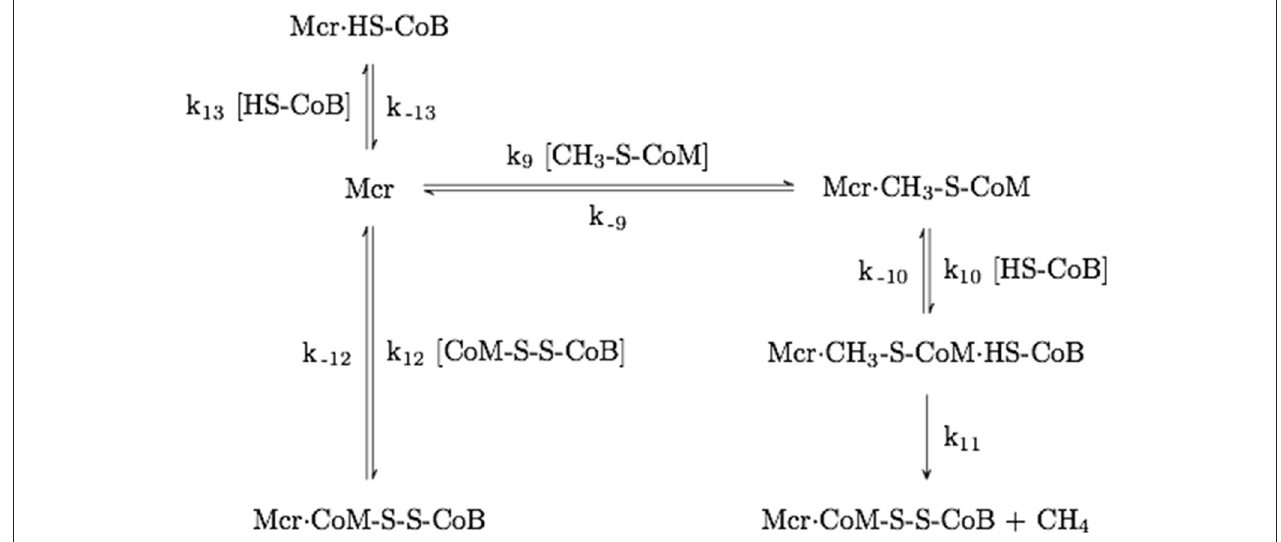
FIGURE 5 | Mechanism of Mcr competitive inhibition by HDS. The rate constant numbering begins with k 9 to avoid ambiguity with the mechanism shown in Figure 4 .